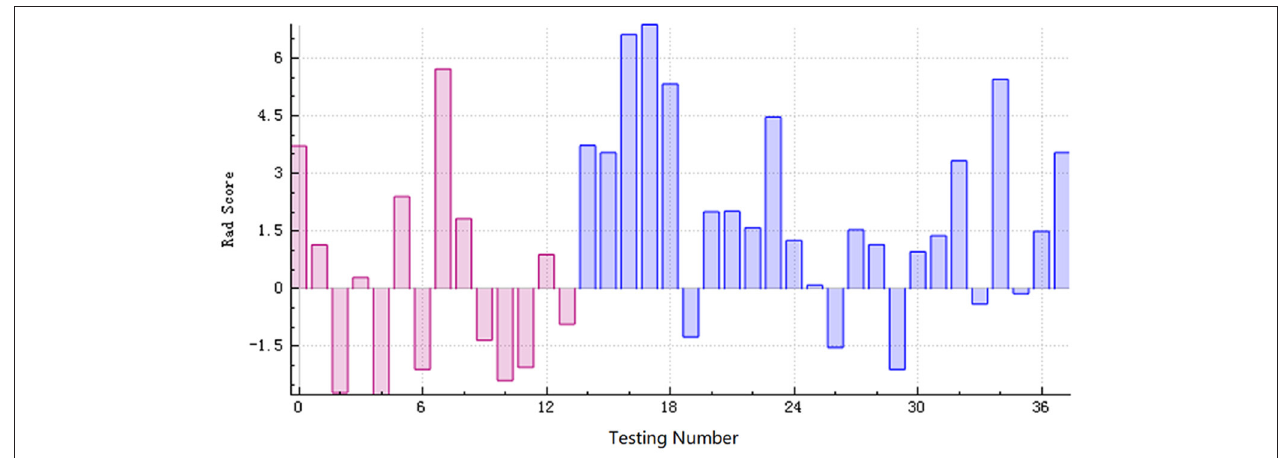
FIGURE 6 | The radiomics score based on the testing data. The red area below the horizontal line and the blue area above the horizontal line represented the accurate prediction. On the contrary, the red area above the horizontal line and the blue area below the horizontal line represented the false